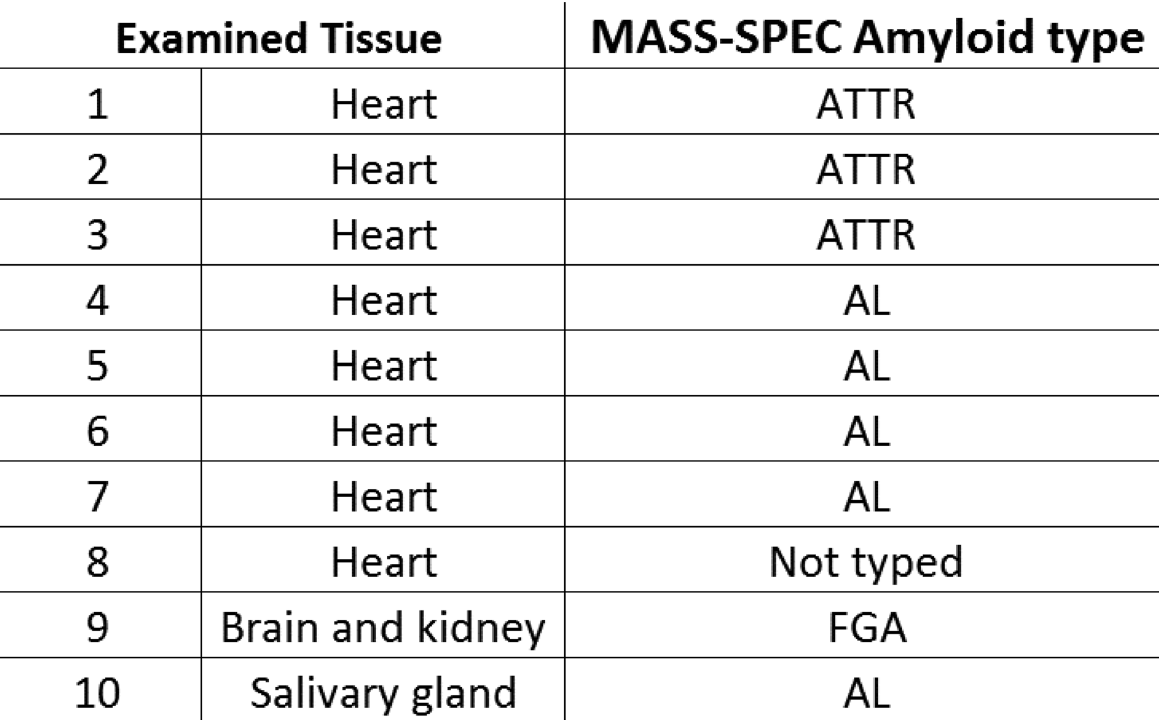
Table 1 List of reviewed cases, tissue examined, and amyloid type